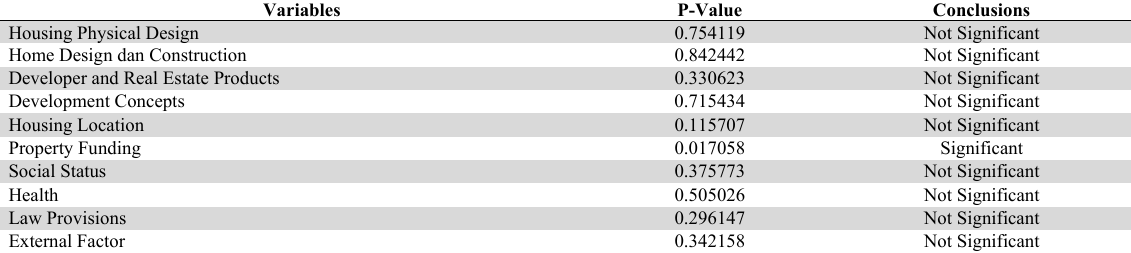
Chi-Square Analysis for Combined